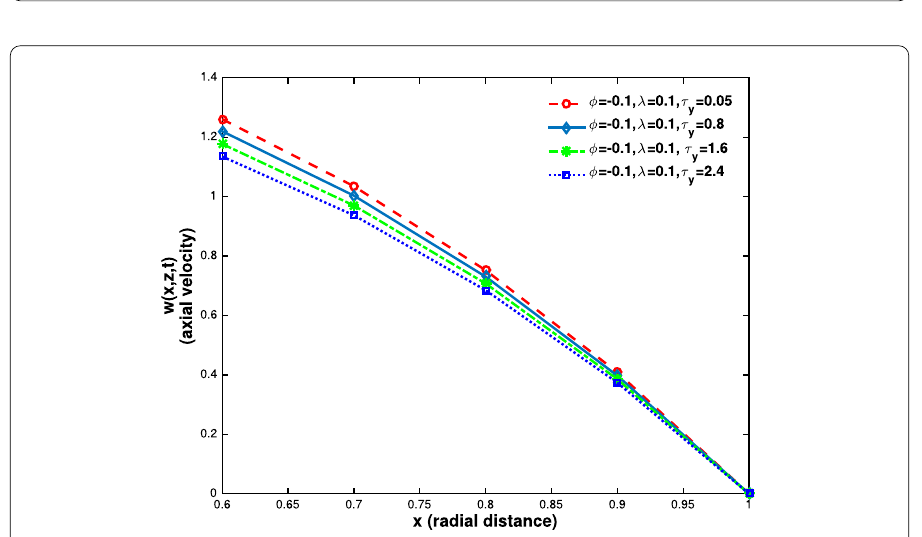
Figure 25 Axial velocity vs radial distances (near wall) for varying yield stress at z = 28, t = 0.45, K = 1.6, φ = –0.1, λ =